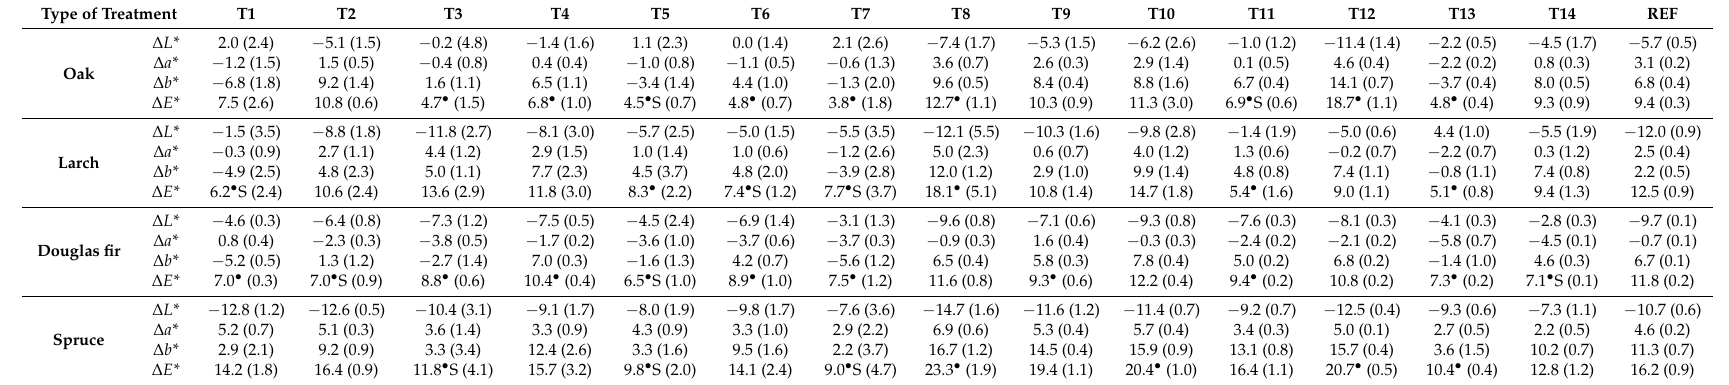
Table 3. Colour changes in tested samples after 320 h of accelerated